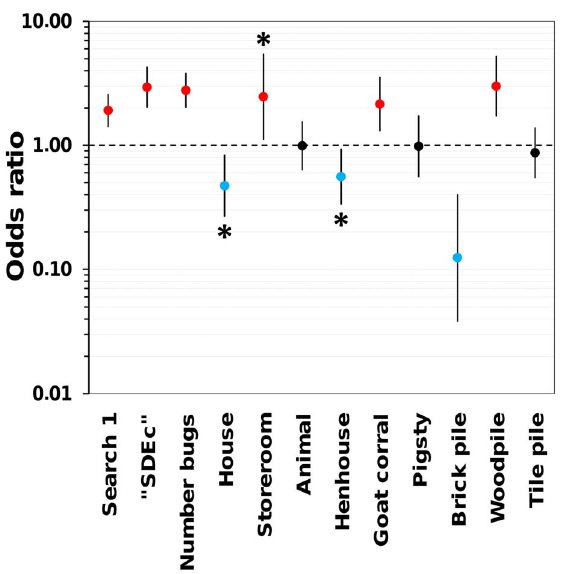
Figure 1. Effects of covariates on the sensitivity of active Chagas disease vector searches in the lower Jaguaribe valley, Ceara´, Brazil: model-averaged odds ratios (ORs) with approx- imate 85% confidence intervals (CIs) based on unconditional standard errors. The effect of a covariate is considered indistinguish- able from zero when the CI crosses the dashed line at OR=1.0 (black circles), positive if all values are . 1.0 (red circles), and negative if all values are , 1.0 (blue circles). Asterisks highlight covariates whose